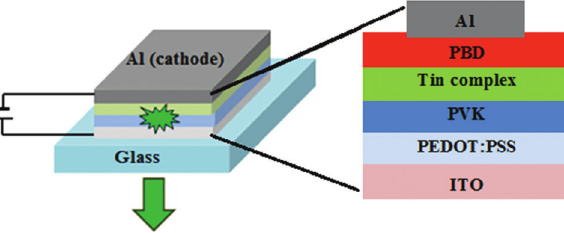
Figure 8: Layer arrangement of the OLED device.